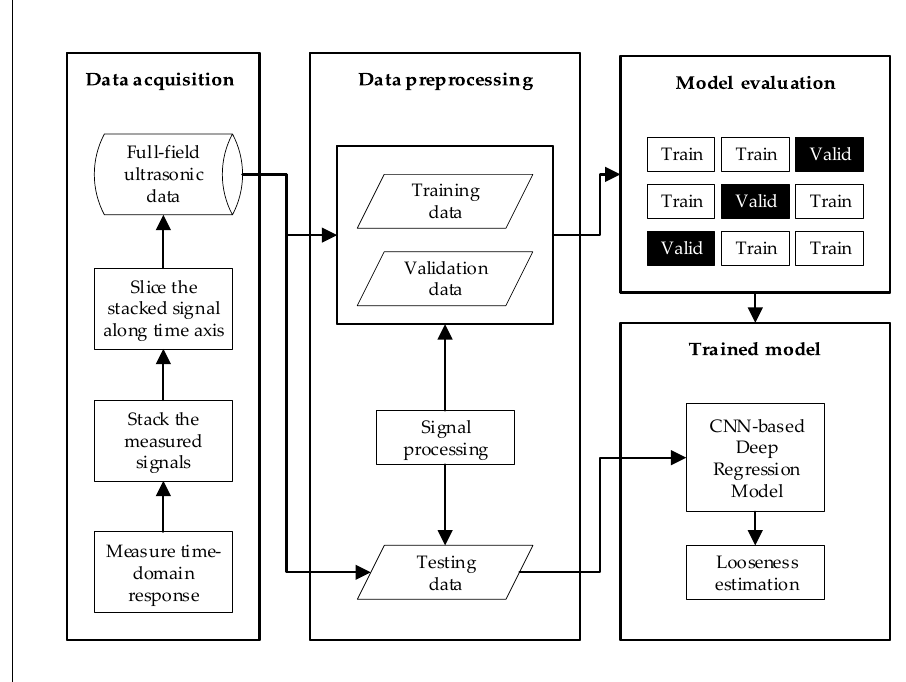
Figure 6. Proposed approach for estimating the looseness of the bolted joints using a deep convolutional neural network